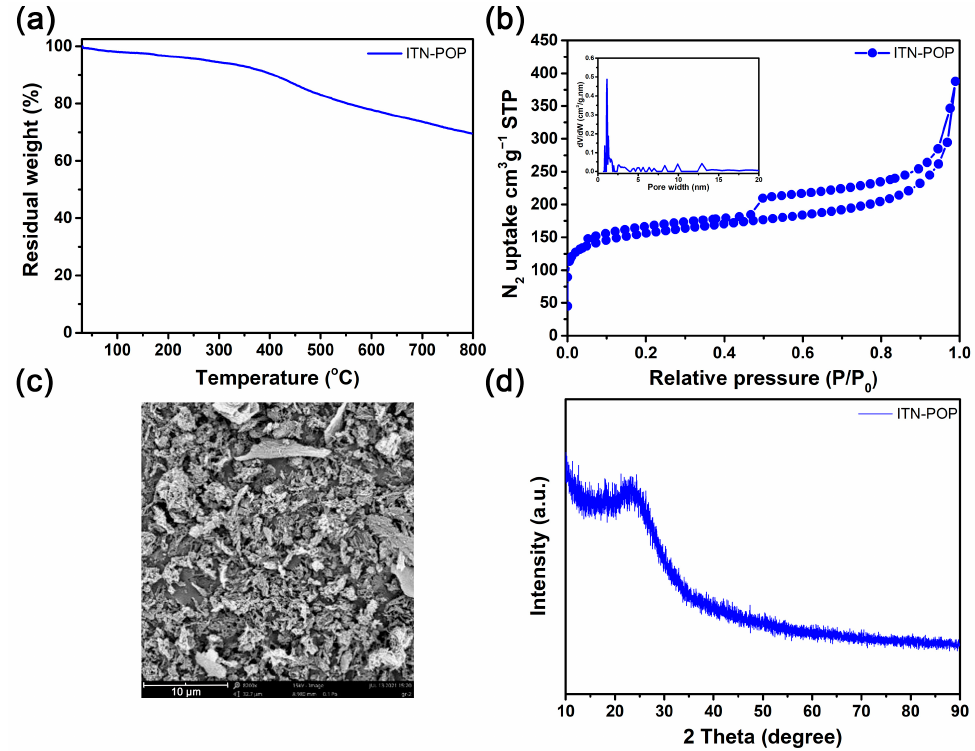
Figure 2. ( a ) TGA curve of ITN-POP; ( b ) N 2 -physisorption isotherm and pore size distribution curve (inset) of ITN-POP; ( c ) SEM image of ITN-POP; ( d ) PXRD spectrum of ITN-POP.